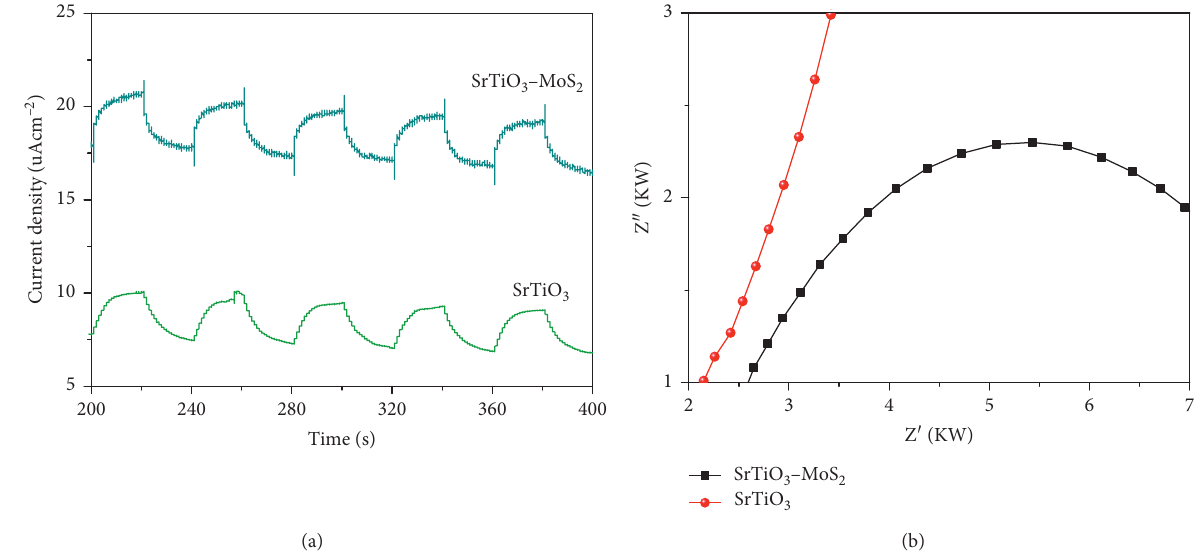
Figure 5: (a) The current density curves as a function of the time for SrTiO 3 and SrTiO 3 @MoS 2 at 1.23V in 1M KOH electrolyte; (b) Nyquist plots of samples at –0.24V versus RHE measured from EIS in the frequency range from 100kHz to